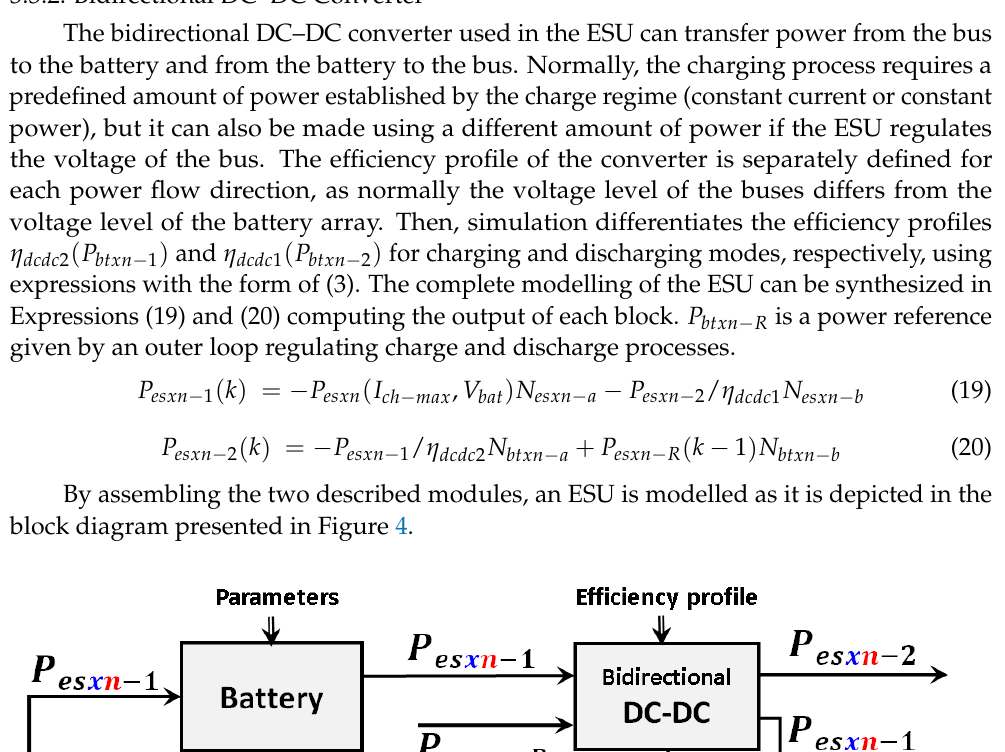
Table 4. Operation modes of the